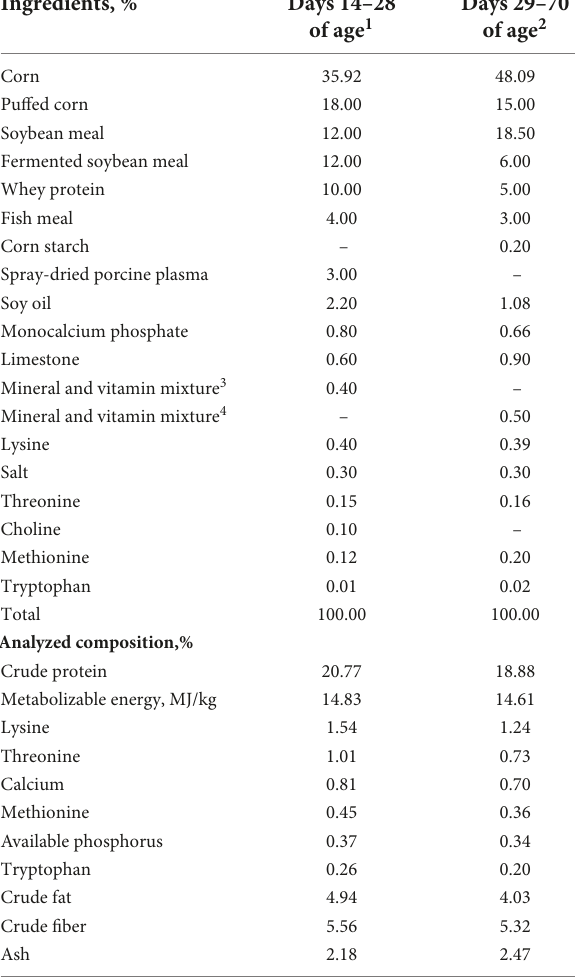
TABLE 1 Composition and nutrient levels of the experimental basal diet during post-weaning period (%, as-fed basis). Ingredients,